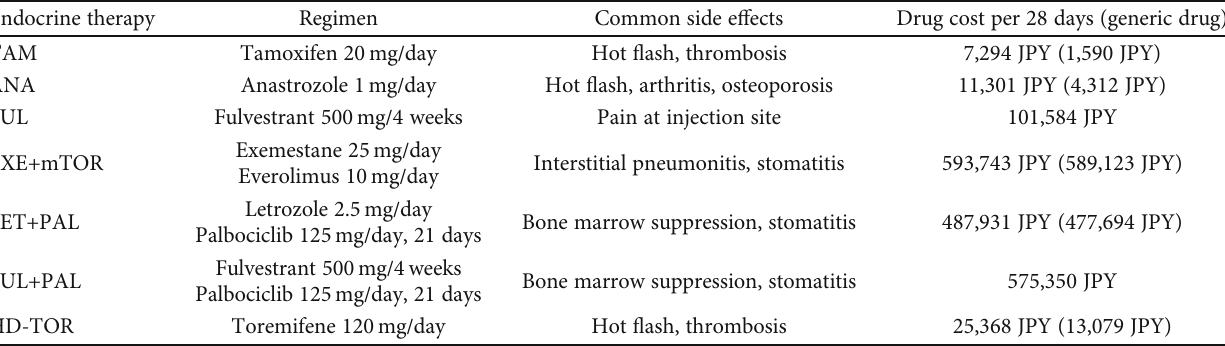
Figure 2: The TTF Kaplan – Meier curves for the primary and secondary AI resistance subgroups. Table 4: Drug cost per month in each common endocrine therapy in Japan on March